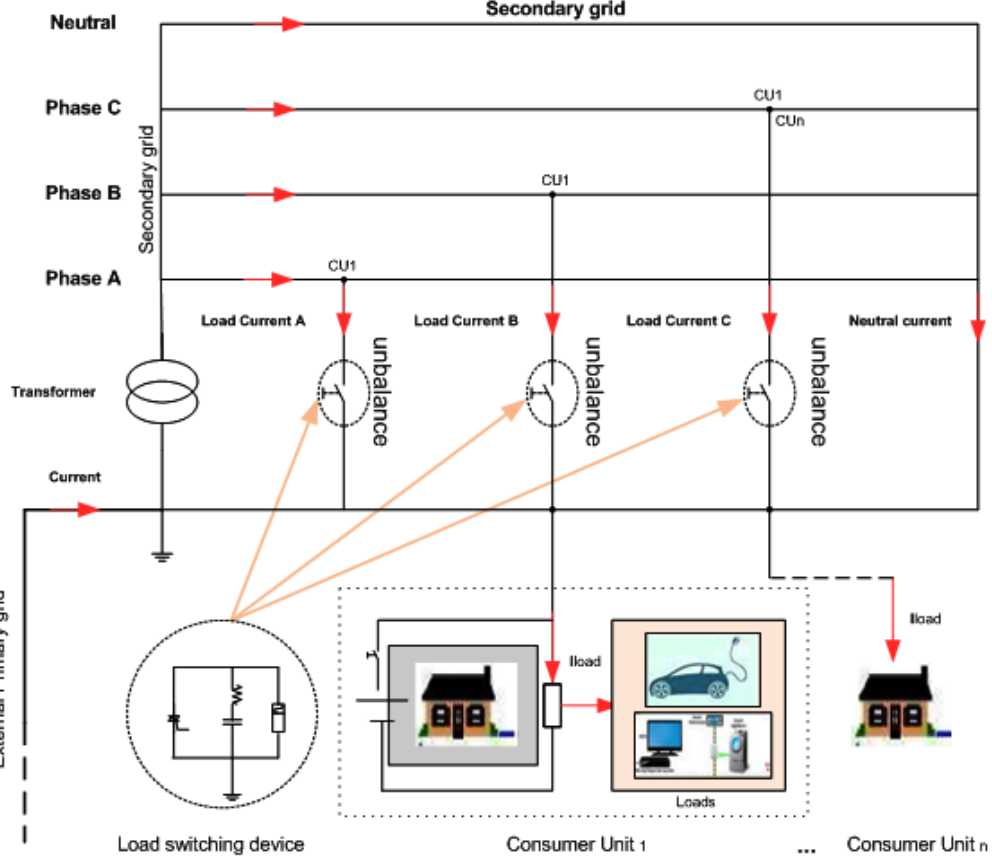
Figure 2. Load imbalance in secondary